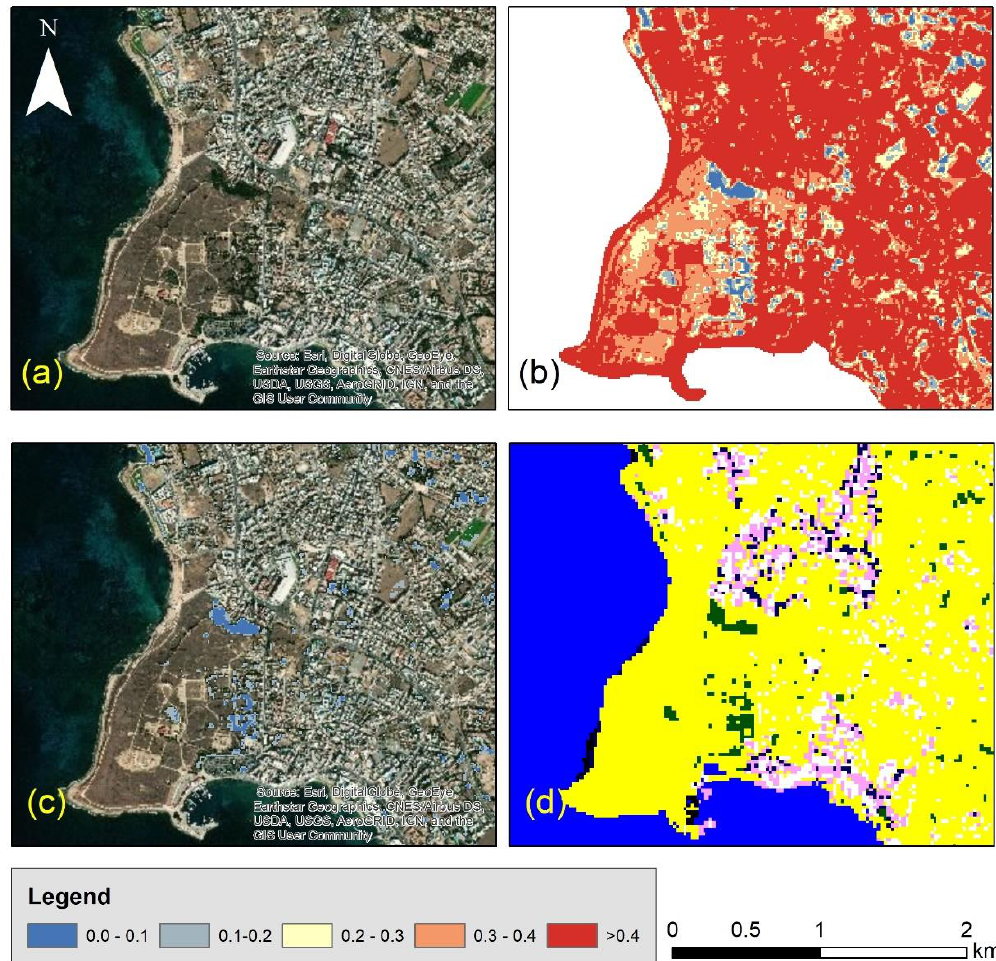
Figure 10. ( a ) High-resolution satellite image over the case study area, ( b ) difference between the results of Figure 9a,b, ( c ) areas with minimum differences between the optical and the radar sensor indicated with blue colour over agricultural areas and ( d ) classification scene of Sentinel-2 images, whereas as vegetated areas are shown with green colour.